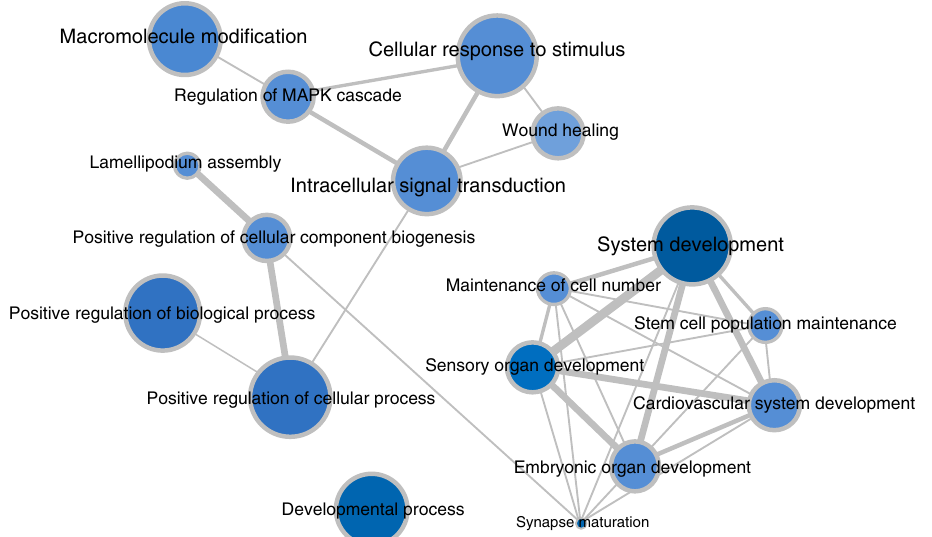
Fig. 7 Gene ontology terms enriched in the CSS/NCBRS methylation pro fi le. The fi gure is generated from a reduced list (redundant GO terms have been removed) of the entire 58 GO terms found to be signi fi cantly enriched, separately, in the three probe-sets related to CSS1, CSS3, and NCBRS (Supplementary Data 5). The color intensity represents the degree of signi fi cance ( p value obtained from a hypergeometric test conducted by missMethyl package). The size of each circle indicates the number of GO terms it was related to before the reduction of the redundant terms was performed. The thickness of the connecting lines corresponds to the level of interactions and relatedness among the pathways. System development followed by regulation of cellular process represent the most signi fi cant GO terms in this analysis. Visualization of the 192 GO terms, found after combining the three probe-sets (Supplementary Data 6), is illustrated in Supplementary Figure